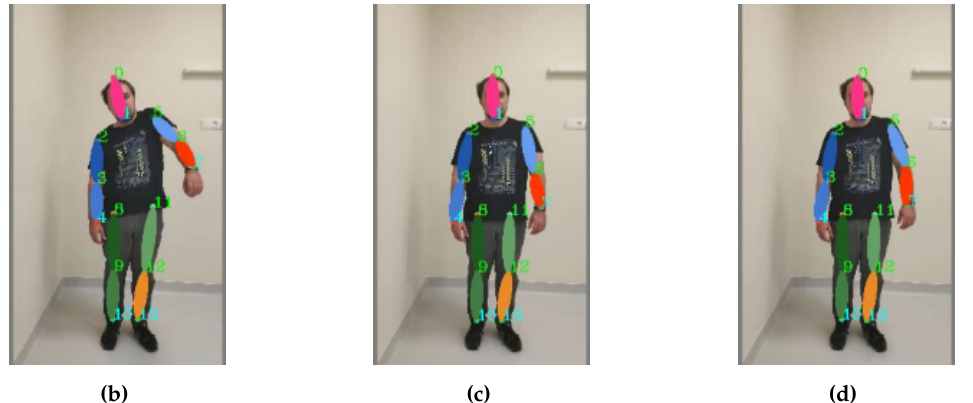
Figure 15. The arm bends with compensatory shoulder support: the motion sequence ( a – d ) starts on the left and ends on the